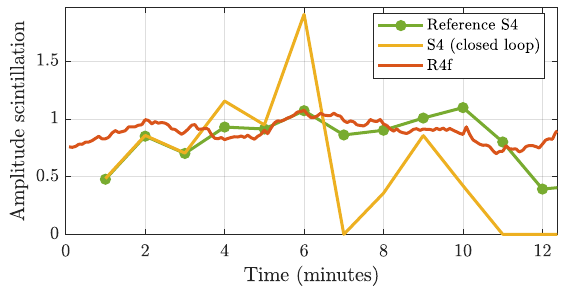
Figure 11. Comparison of S 4 and R 4 parameters after filtering, for a LoL